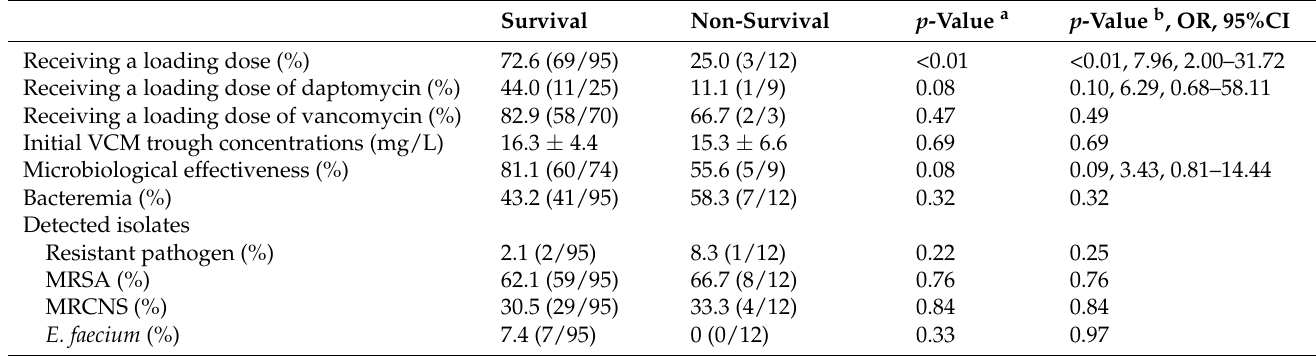
Table 4. Comparison of survival and non-survival groups.